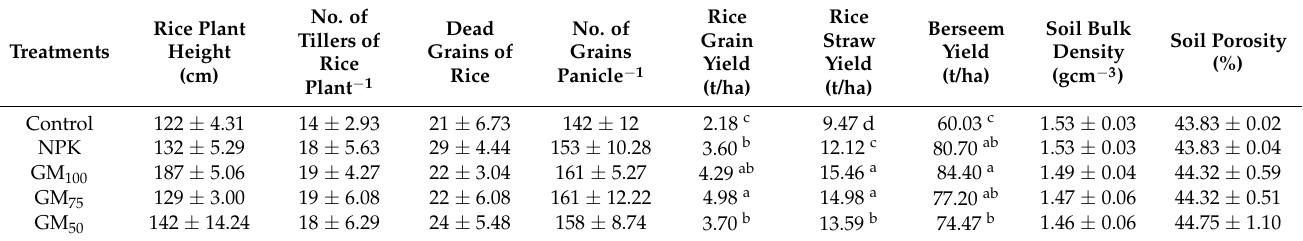
Table 2. Effect of green manuring on soil properties, plant growth, and yield parameters of rice and berseem crops (average of three years) from 2015 to